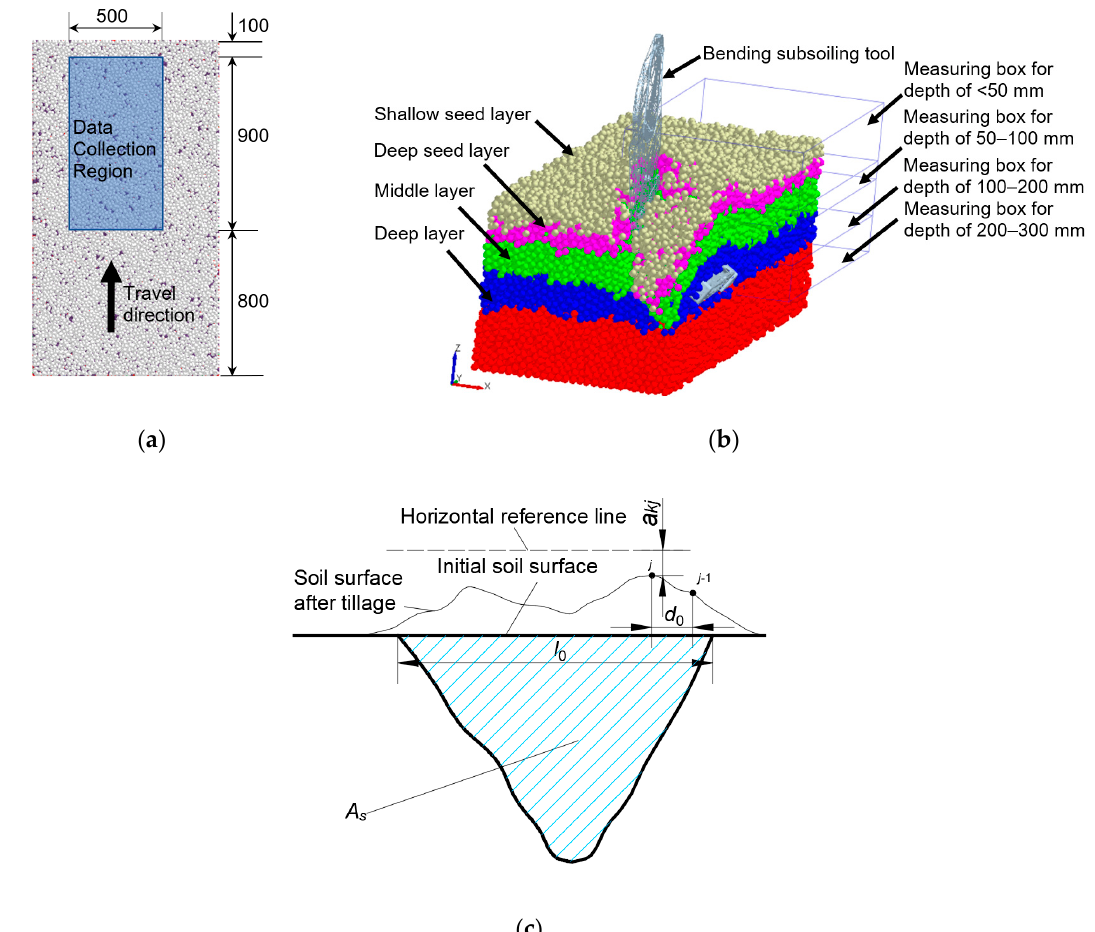
Figure 5. The ( a ) data collection region in the top view, ( b ) measuring box of particles mass for each depth and ( c ) diagram showing the vertical distance from soil surface after tillage to horizontal reference line ( a kj ) and the spacing between two adjacent points ( d 0 ), furrow width ( l 0 ) and soil disturbance area ( A s ).